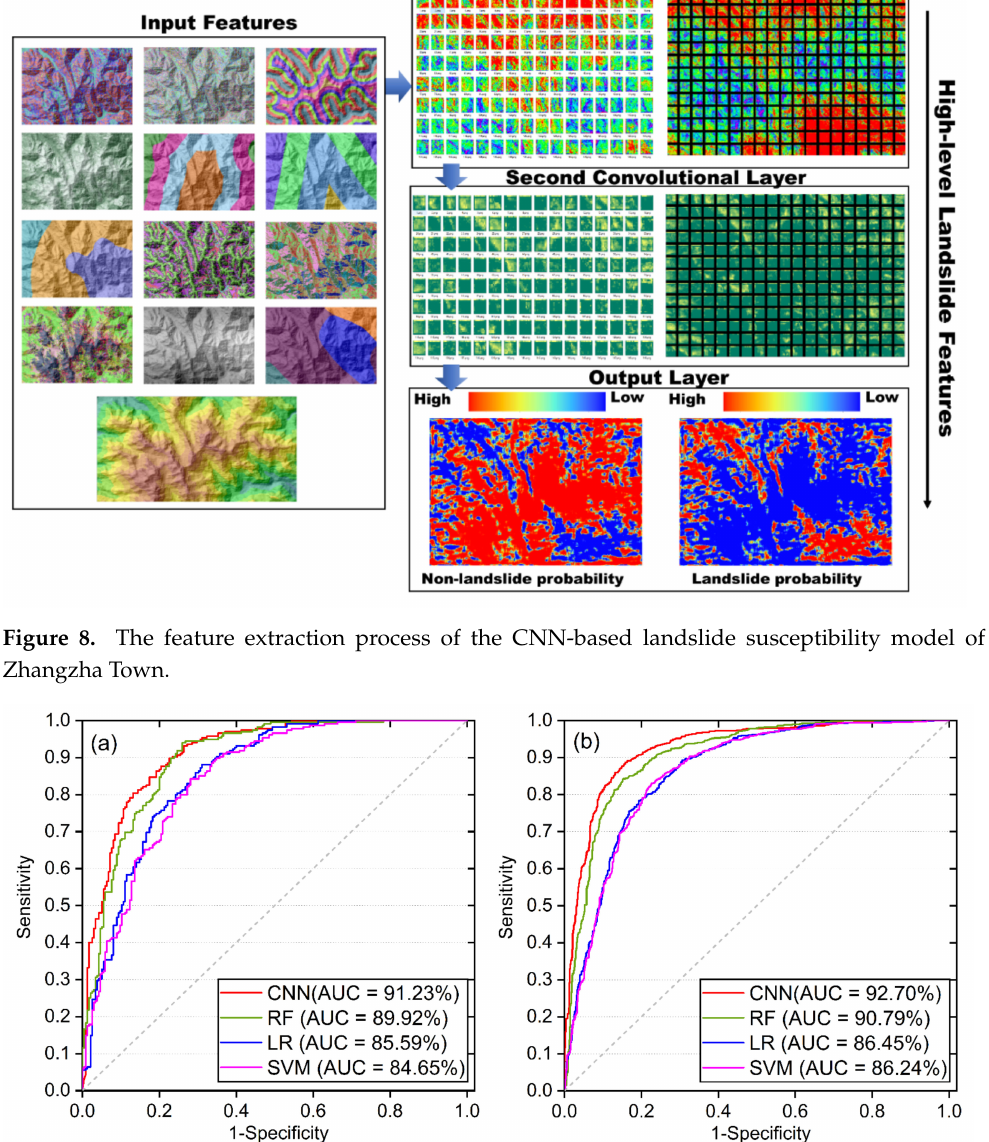
Figure 9. ROC curves of different models on the testing dataset for ( a ) Zhangzha Town and ( b ) Lantau